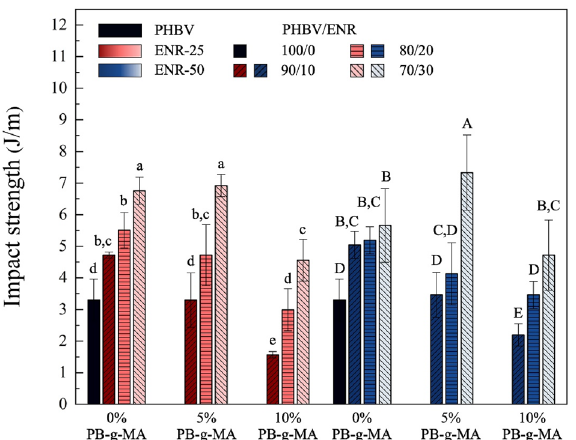
Figure 7. The impact strength of PHBV/ENR blends. Data are presented as mean ± SD. Groups designated with different letters are significantly different using One-Way ANOVA with Duncan’s multiple range post hoc (at p < 0.05, n = 3).